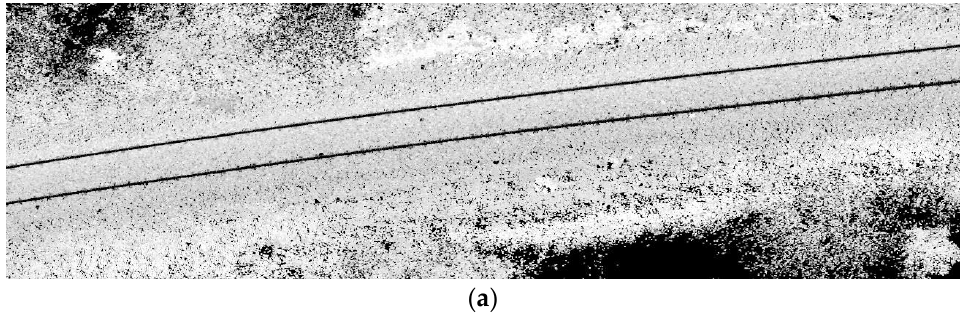
Figure 1. Laser sensor working principles schema: ( a ) Mirror rotation movement deflecting the emitted ( red ) and received ( green ) pulse; ( b ) Schematic representation of the reflected pulses creating a profile effect, coloured by the scan angle (grey pulses are not reflected to the sensor). The point cloud effect results from the train movement through consecutive